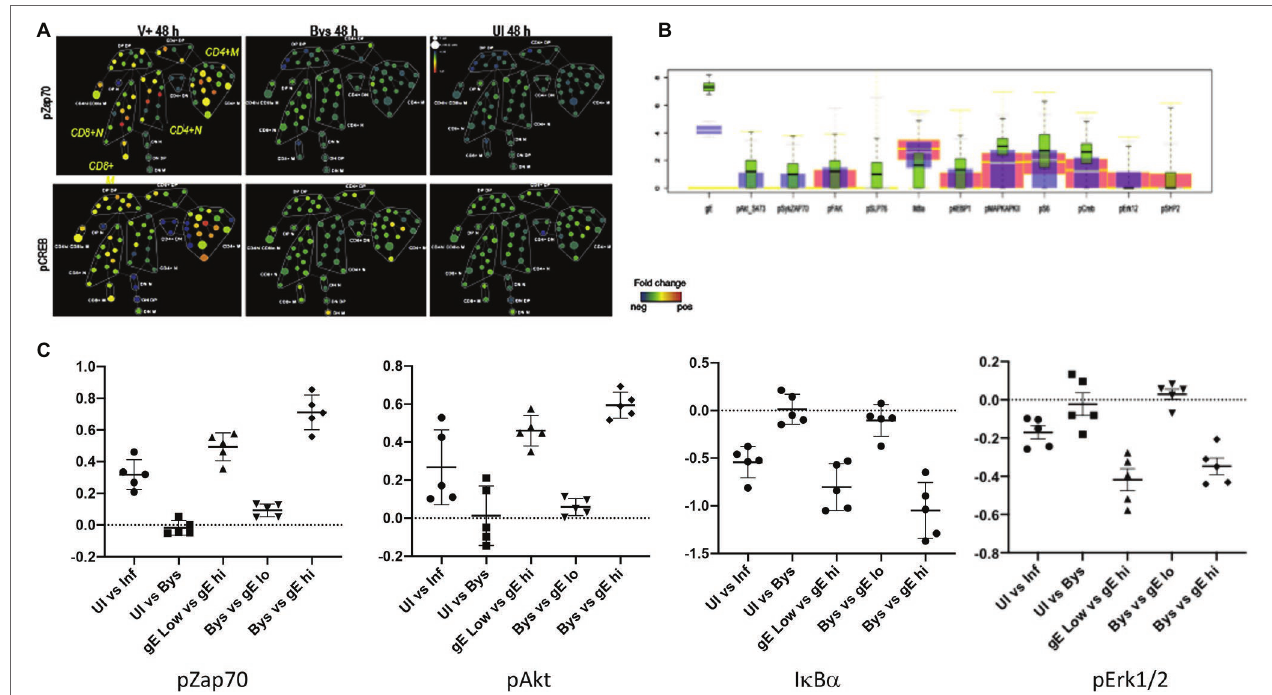
FIGURE 7 | VZV induces signaling through the T cell receptor (TCR) pathway. (A) SPADE tree showing the fold-change in expression levels of pZap70 and pCREB in VZV-infected and bystander T cells relative to mock-infected T cells by SPADE analysis. In this case, the node colors indicate fold-change in expression in phosphorylated proteins, from minimum (blue) to maximum (red, relative to the mock-infected cells). (B) The box plots show the differential expression of the individual phosphoproteins between the mock-infected (red) and VZV-infected low-gE expressing (blue) and high-gE expressing (red) cells. (C) Effect size of the indicated proteins when compared between the indicated groups of cells (x-axis), where the data plotted on y-axis is of the second group compared to the first